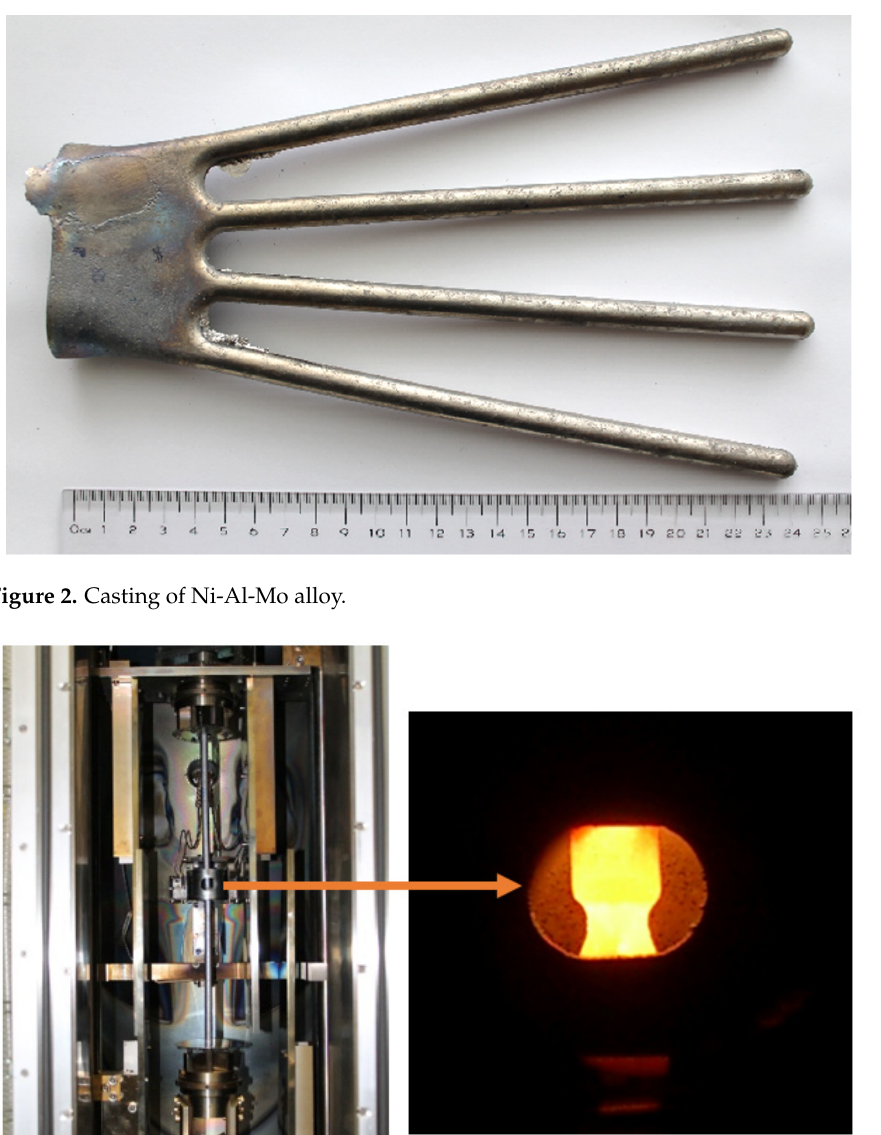
Figure 3. The placement of s ample in the EBFZM furnace and the shape of melting zone. Table 1. Characterization of prepared alloys and sample Table 1. Characterization of prepared alloys and sample identification.